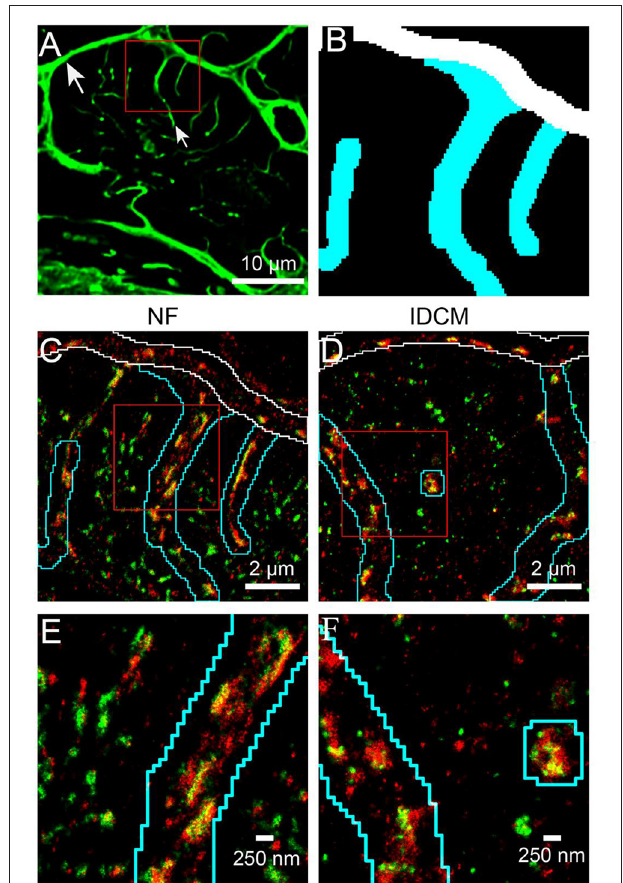
FIGURE 1 | Super-resolution imaging of RyR and JPH in donor and IDCM human cardiomyocytes segmented into t-tubular, sarcolemmal and corbular SR regions. (A) Confocal imaging of the WGA labelled donor cardiac myocyte (transversely orientated). The WGA labelling identifies the sarcolemma (large arrow) and t-tubules (small arrow). (B) Binary mask of regions near t-tubules (cyan), surface sarcolemma (white) and corbular SR (Black) generated from the WGA labelling of the red box in “ (A) ”. (C) Super-resolution imaging of RyR (green) and JPH (red) in donor myocyte indicated by the red box in “ (A) ”.